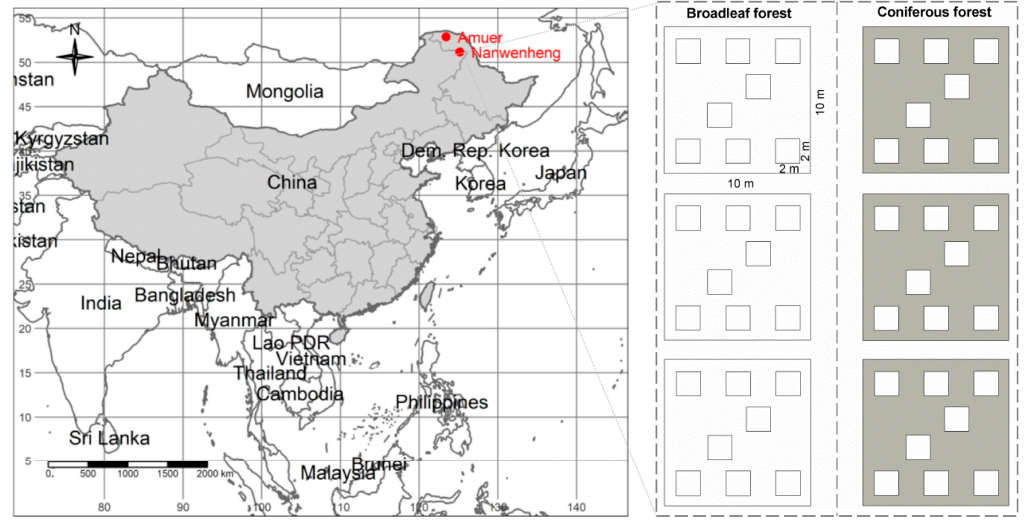
Figure 1. Geographical location of study sites and sampling methods. Amuer, the site at higher latitude; Nanwenghe, the site at lower latitude.